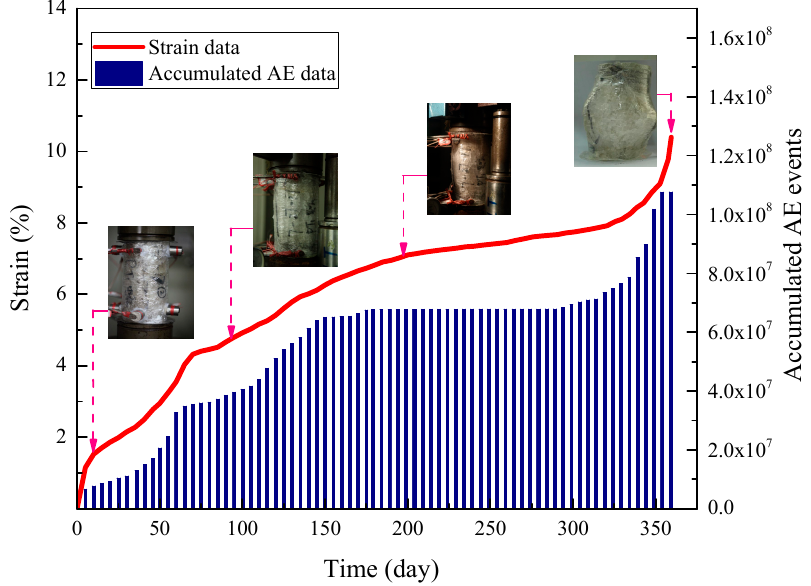
Figure 2. The deformation characteristics of salt rock during the creep process.